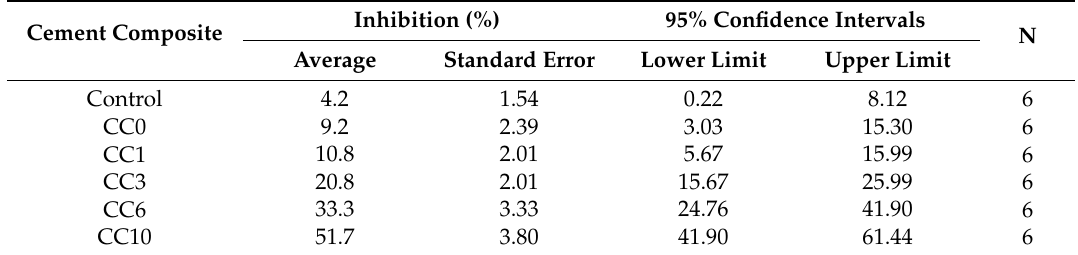
Table 11. Basic statistical characteristics of acute toxicity test results of Dafnia